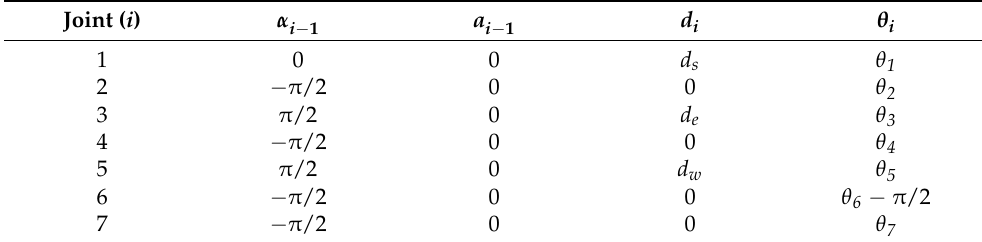
Table A2. Modified Denavit–Hartenberg